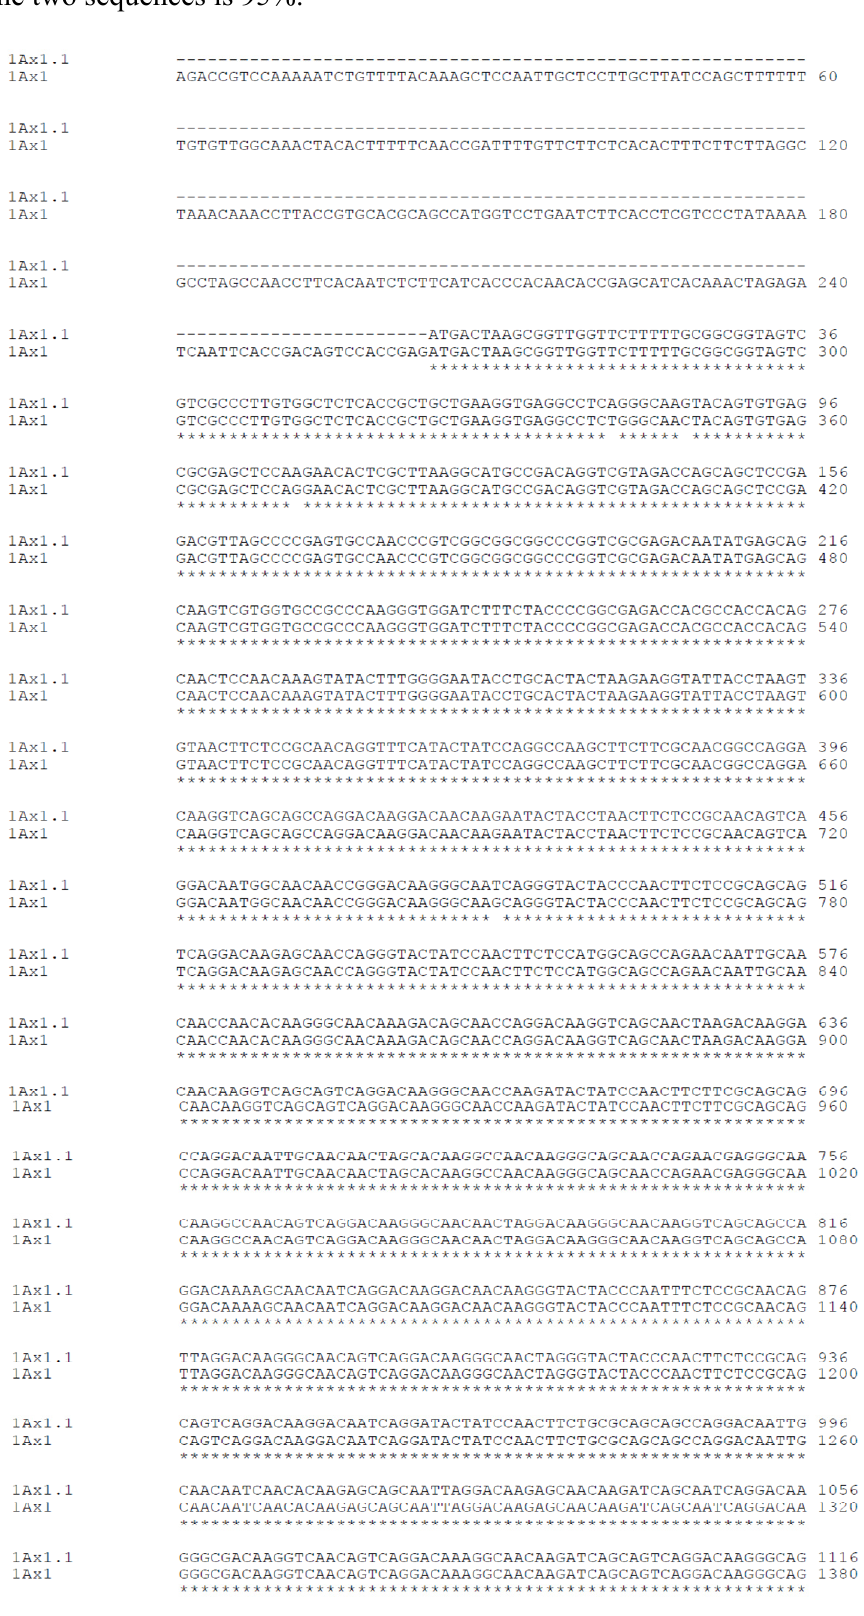
Figure 5. Alignment of 1Ax1.1 (GenBank ® accession no. JN172932.1) and 1Ax1 (GenBank® accession no. X61009.1) HMW-GS nucleotide coding sequences. The identity between the two sequences is